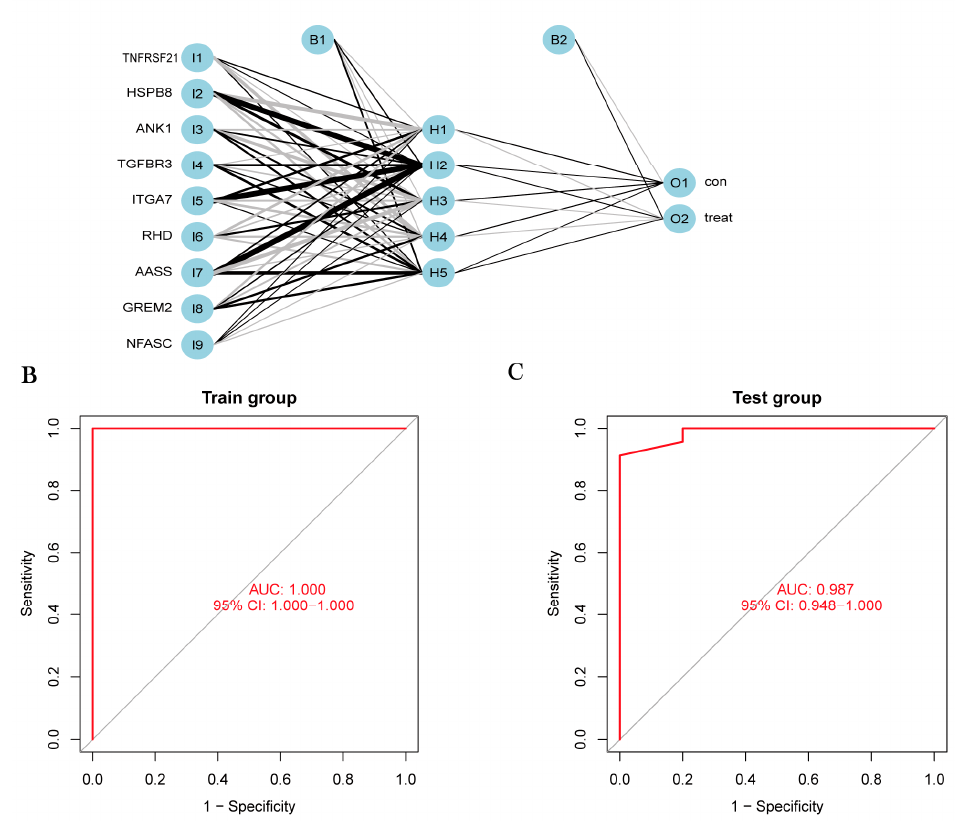
Figure 6. ( A ) Visualization results of the artificial neural network we constructed. ( B ) AUC of the training group after verifying the model. ( C ) AUC of the validation group after verifying the